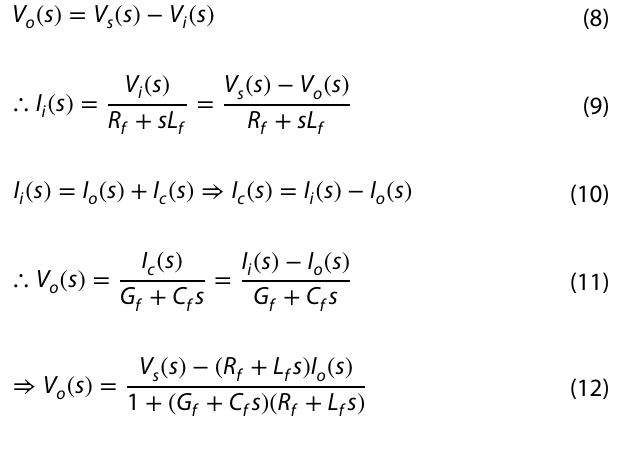
Table 2 Assumptions for the design of proposed method S. No